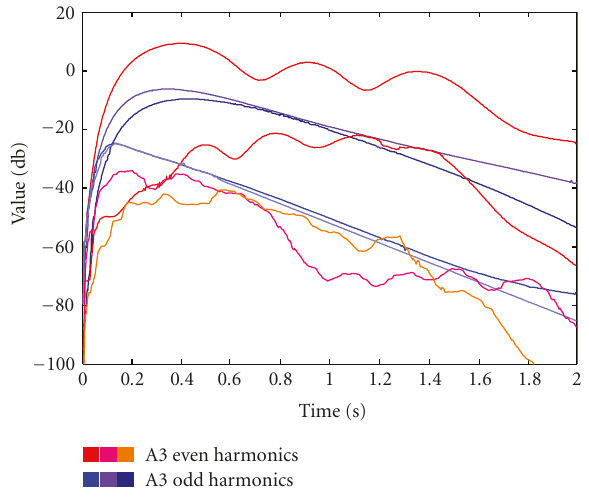
Figure 8: Energy changes of harmonic components of a polyphonic note with two polyphonies A3 and